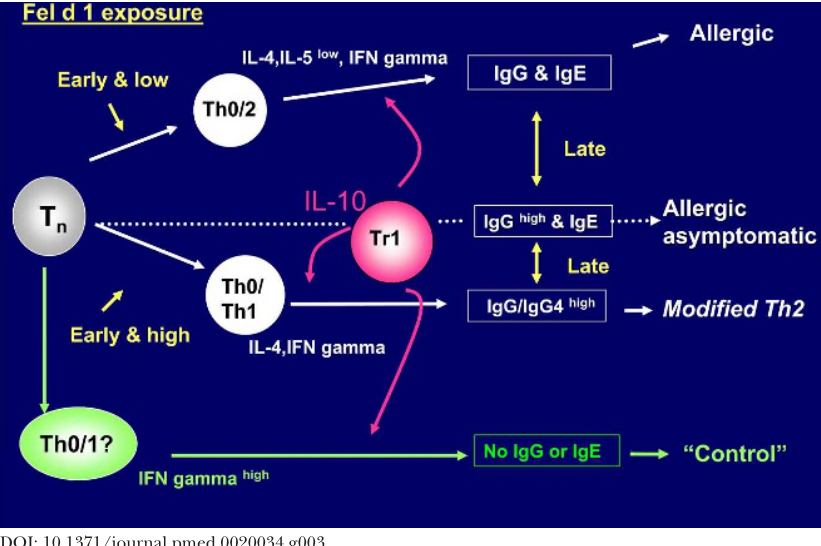
Figure 3. Mechanisms of T Cell Control over the Hypersensitivity Response to Cat Allergen The response to cat allergen, Fel d 1, includes T cells that produce high levels of IL-10 that have some of the features of the T regulator one cells (Tr1). However, these cells appear to be a feature of both allergic and non-allergic responses, implying that the whole response to cat allergen is controlled. Some of the effects of cat exposure may need to occur early, but other studies suggest strongly that the different responses can change following a prolonged change in exposure late in